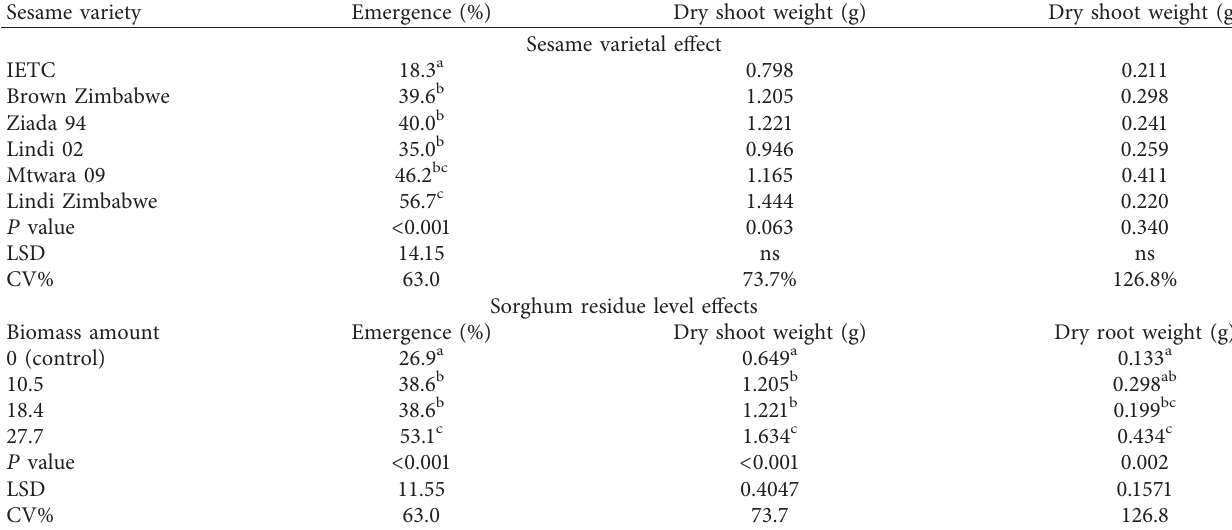
Table 4: Effect of soil incorporated sorghum biomass on the final emergence, shoot dry weight, and root dry weight of six sesame varieties. Sesame variety